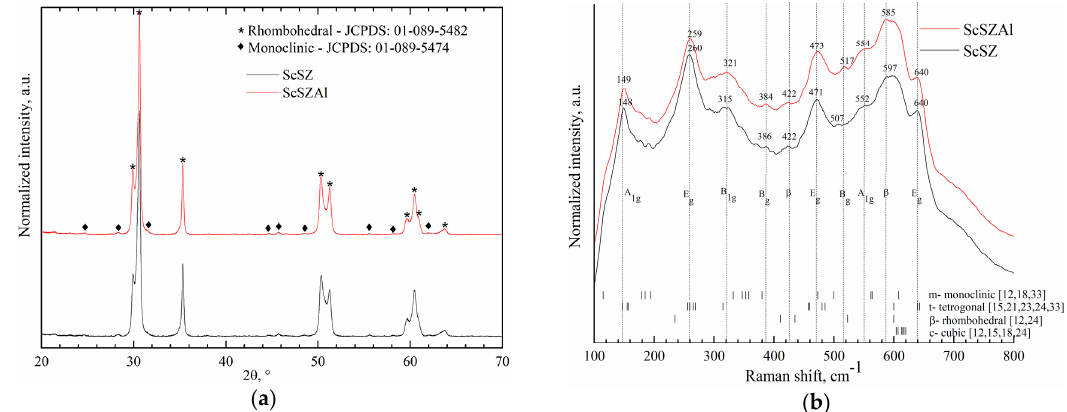
Figure 1. ScSZ and ScSZAl powders: ( a ) X-ray diffraction (XRD) patterns and ( b ) Raman shifts.